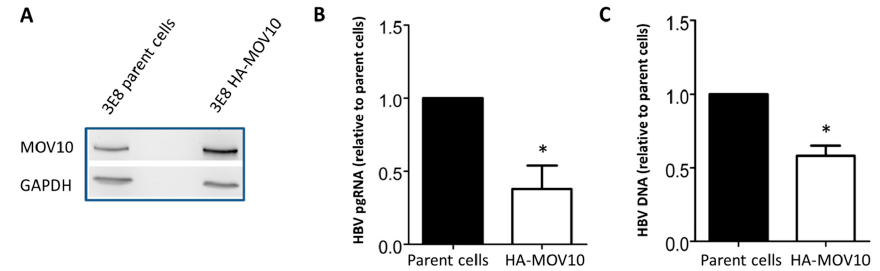
Figure 5. MOV10 over-expression diminishes HBV infection of HepG2-NTCP cells. HepG2-NTCP-3E8 parent cells and HepG2-NTCP-3E8 HA-MOV10 cells were infected with 400 HBV genome equivalents per cell. Five days later, cells were collected. ( A ) Western blot showing MOV10 expression in 3E8 HA-MOV10 stable cell line compared to HepG2-NTCP-3E8 parent cells. GAPDH was used as a loading control ( B ) Intracellular HBV pgRNA level determined by RT-qPCR. Data were normalized to GAPDH